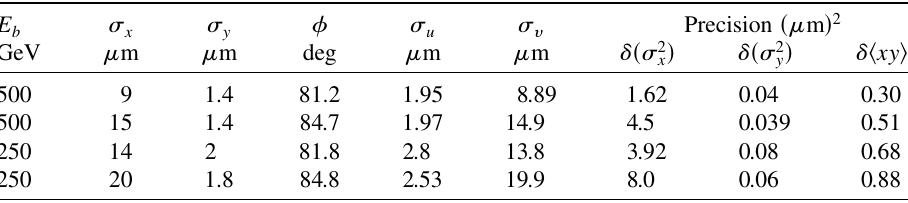
TABLE II. The relevant measurables for emittance measurement under the approximation ’ 0 for a set of electron beam sizes of interest at the ILC for the given beam energies E (cid:2) xy quoted precisions for (cid:8) h xy i are those obtainable if each of the dimensions (cid:2) h xy i measured to 1%. The corresponding precisions for (cid:8)(cid:2) 2 x